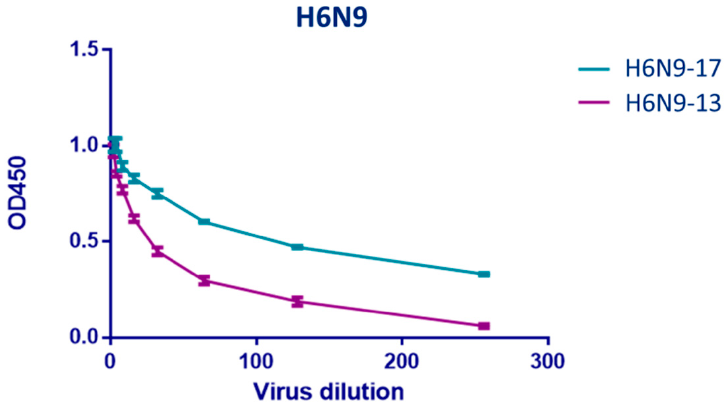
Figure 2. Dependence of the result of an enzymatic reaction on the dilution of viruses H6N9-13 and H6N9-17. The starting concentration of the influenza virus was 256 HAU.